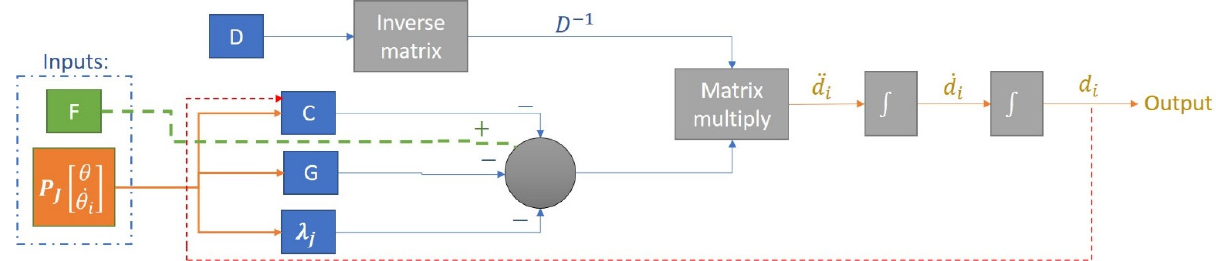
Figure 5. Plant’s block diagram. Forces and passive joints estimated by a controller and the inverse kinematics equation system, respectively, input the plant. Real position of limbs exits the plant.